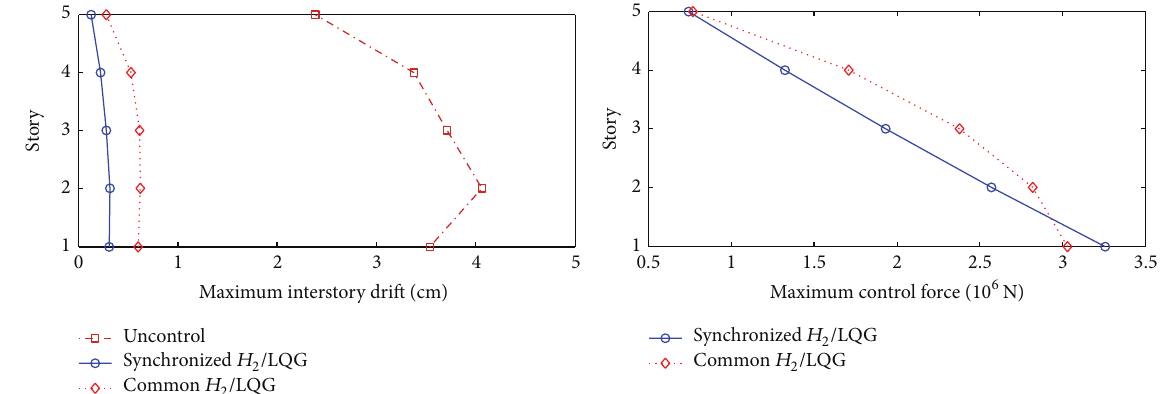
Figure 16: Maximum absolute interstory drifts and control efforts in El Centro Earthquake (1940).